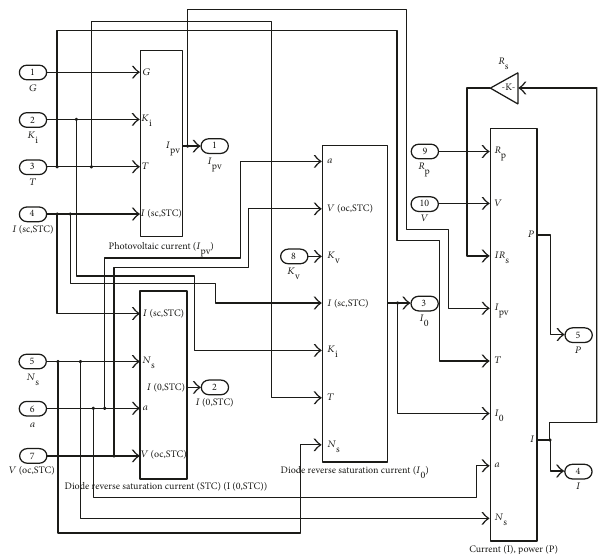
Figure 9: PV module model with subsystems in MATLAB/ Simulink that solves the I-V